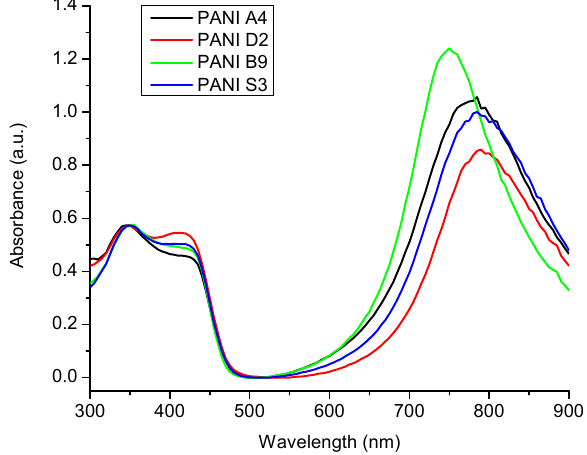
/ Visible spectra of PANI A4, PANI D2, PANI B9 and PANI Figure 4. UV/Visible spectra of PANI A4, PANI D2, PANI B9 and PANI S3. Figure 4. UV Figure 4. UV/Visible spectra of PANI A4, PANI D2, PANI B9 and PANI S3.